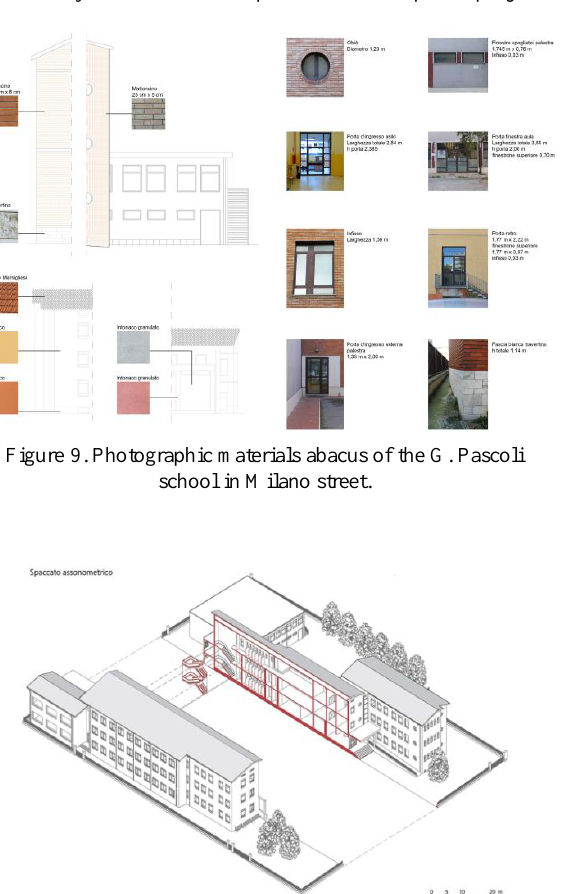
Figure 8. photoplane of the school Borgomarino facades. Murales by the Millo artist as part of a redevelopment project.